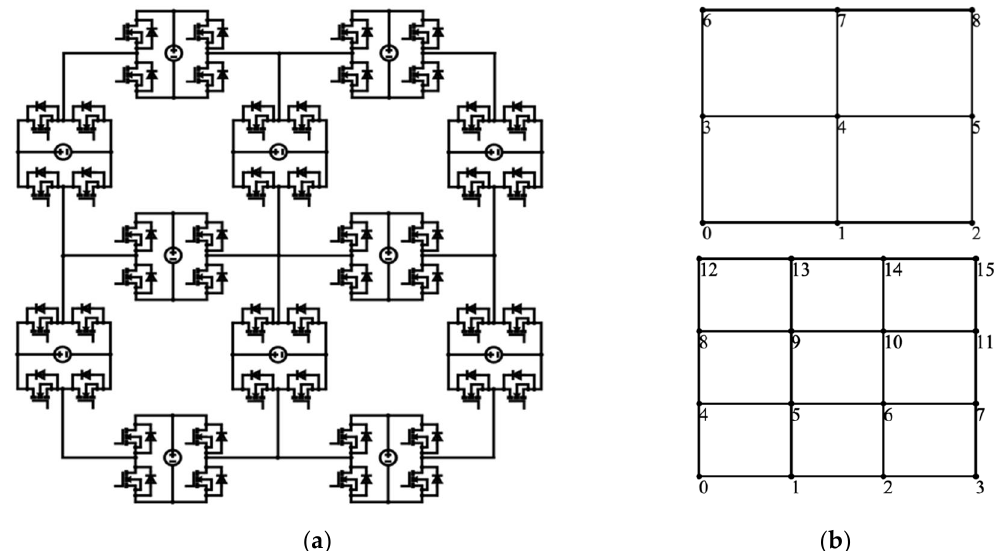
Figure 1. Schematics of Lattice Converters: ( a ) Example of 3 × 3 Lattice Converter wiring diagram. Each edge is an H-bridge converter, shown with more details in Section 2.1; ( b ) Schematic of a 3 × 3 Lattice Converter (Above); Schematic of a 4 × 4 Lattice Converter (Below).